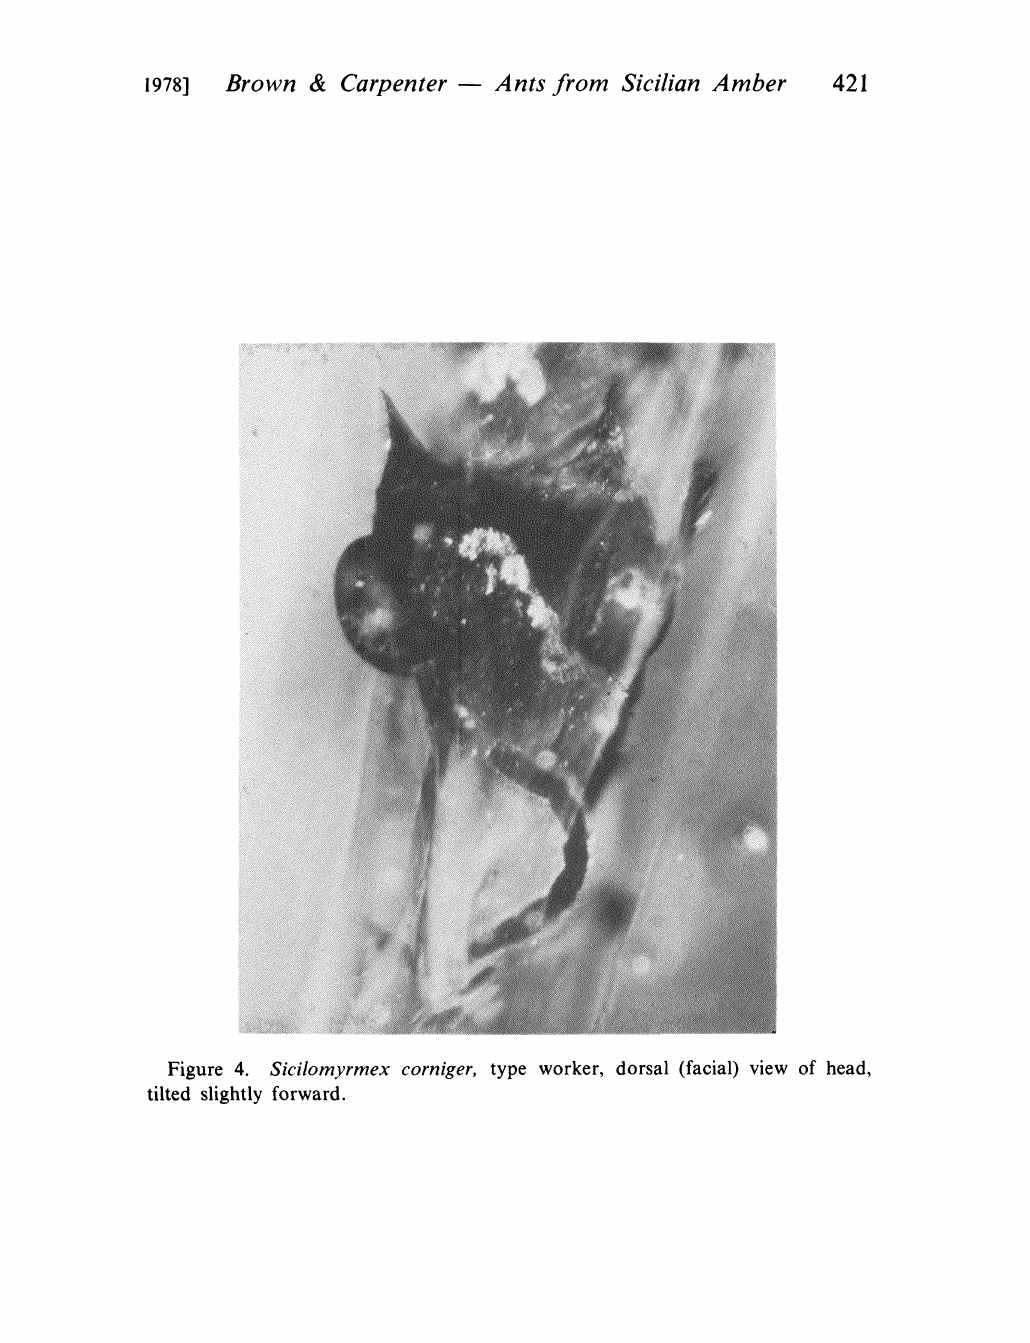
Figure 4. Sicilomyrmex corniger, type worker, dorsal (facial) view of head, tilted slightly